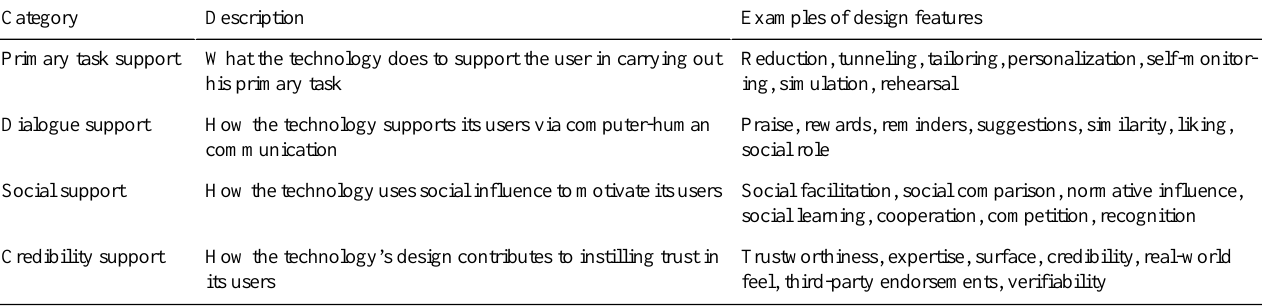
Table 1. Overview of the categories of the Persuasive Systems Design